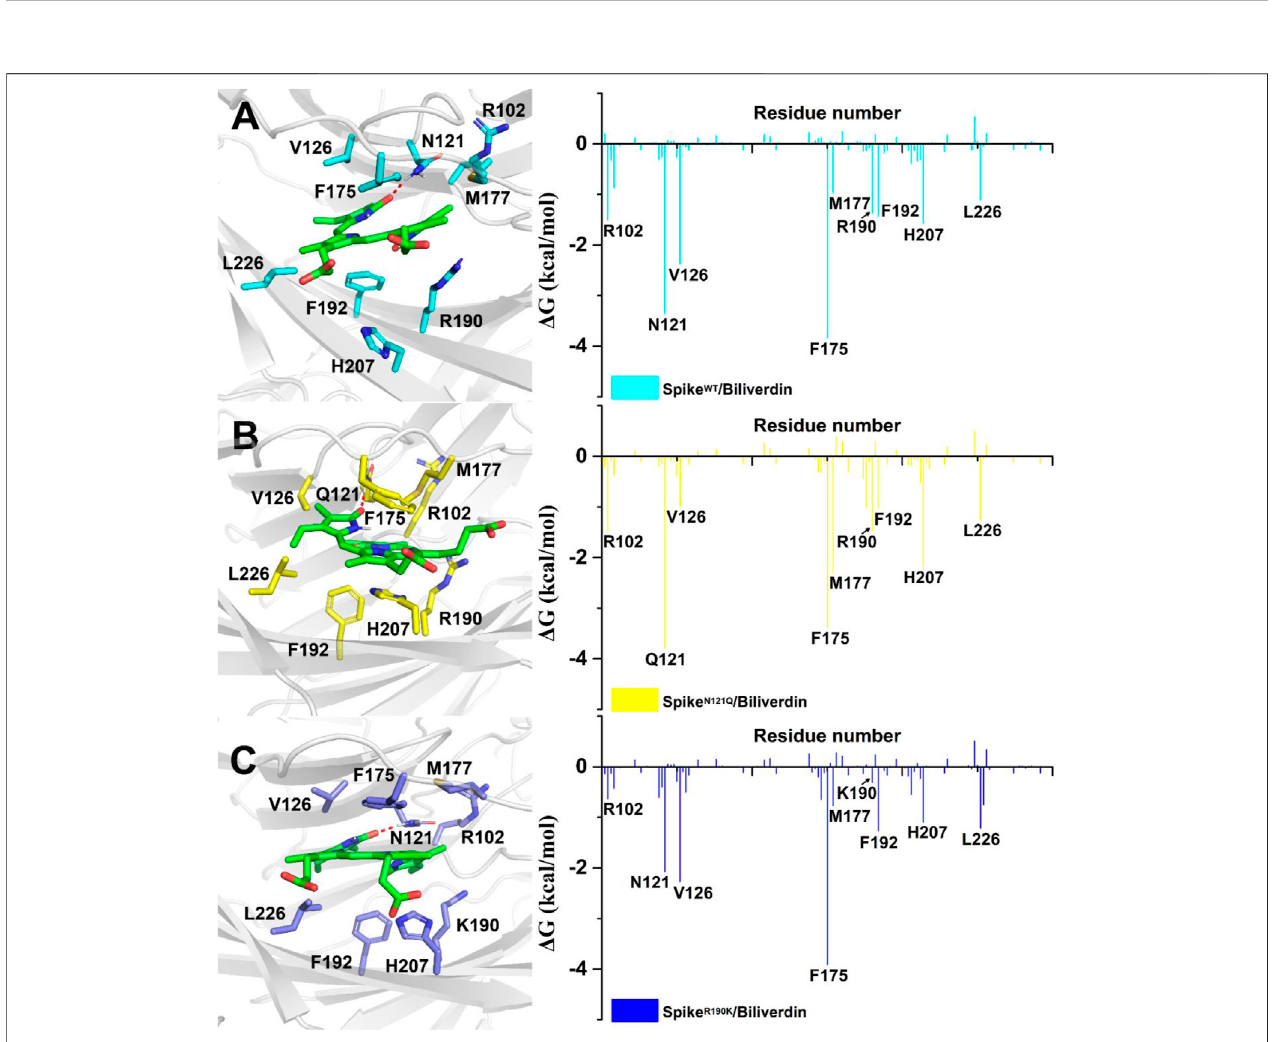
FIGURE 3 | Residues around biliverdin and MM/GBSA decomposition results of the total binding free energies per residue for (A) Spike WT /Biliverdin, (B) Spike N121Q /Biliverdin, and (C) Spike R190K /Biliverdin.